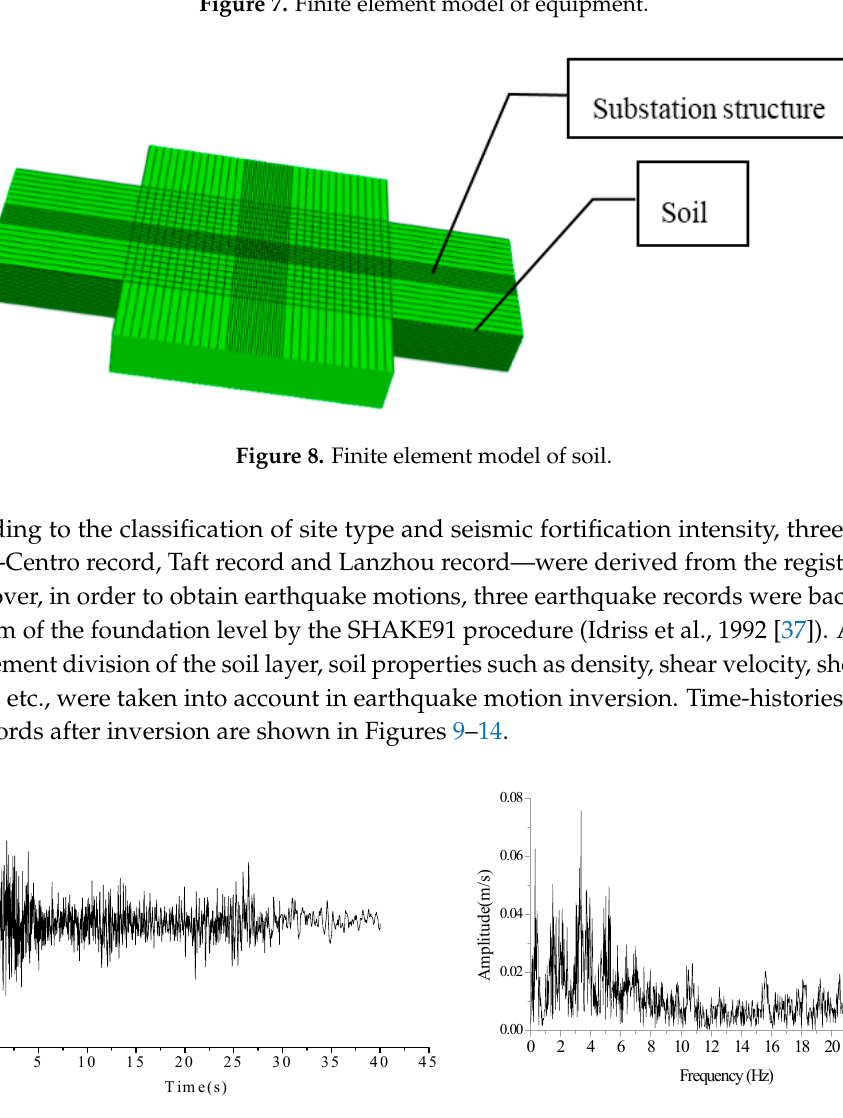
Appl. Sci. 2017 , 7 , 1044